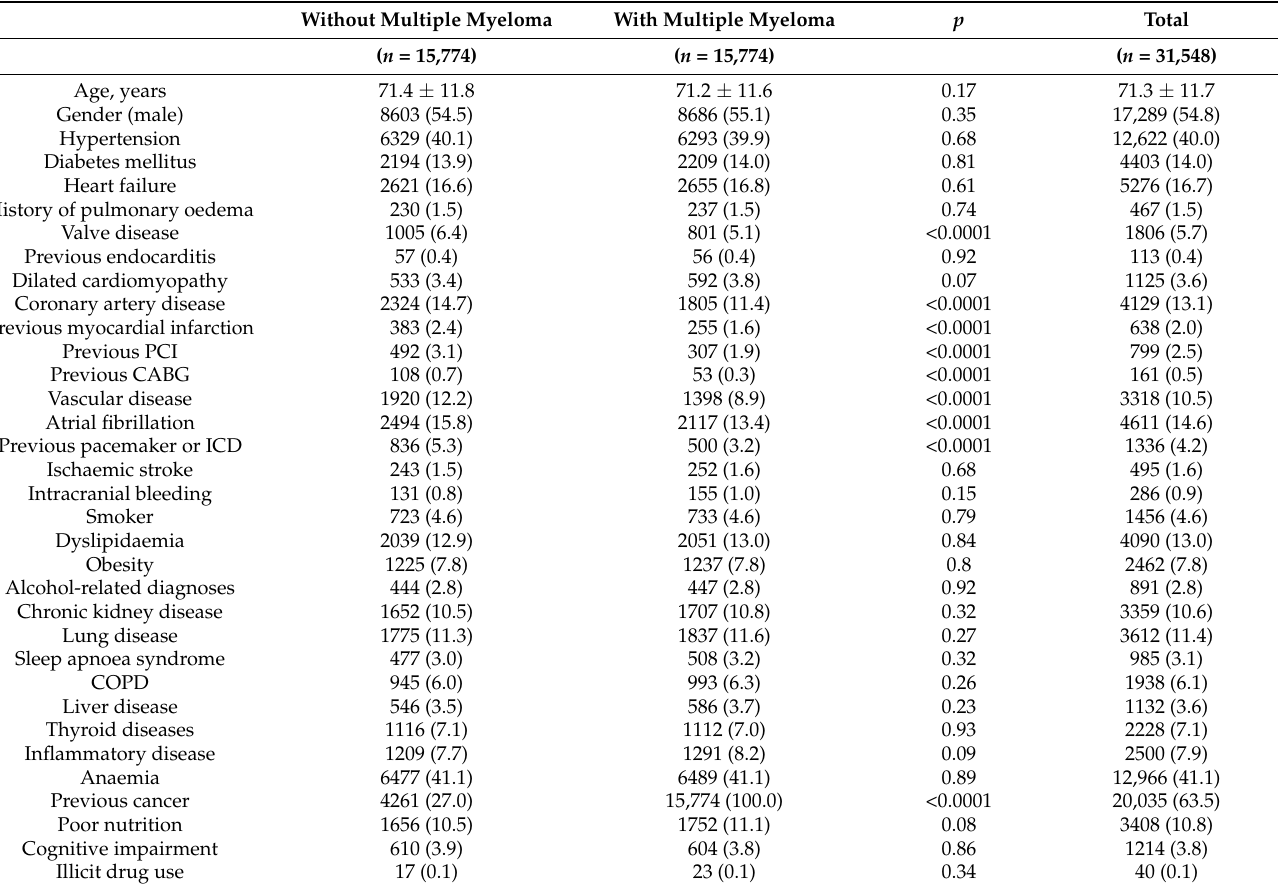
Table 2. Baseline characteristics in the matched population.